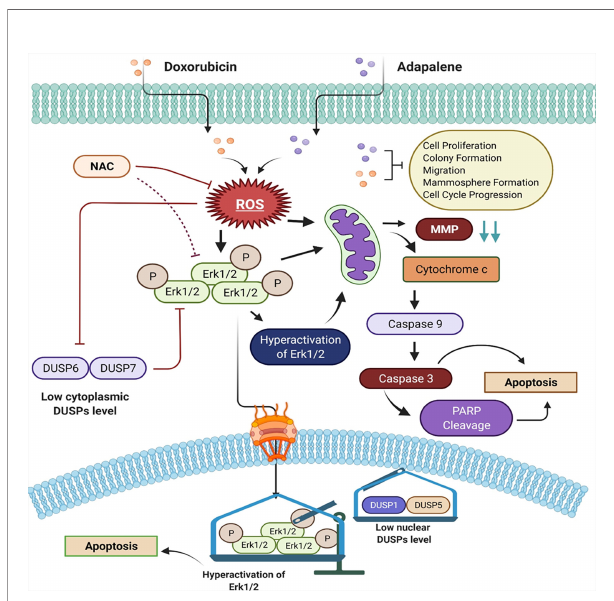
FIGURE 8 | Schematic of the main fi ndings of the study and possible mechanism of action of doxorubicin and adapalene in TNBC cells. The co- treatment with DOX and ADA resulted in enhanced ROS generation, leading to mitochondrial membrane potential disruption. Disruption of MMP triggers intrinsic apoptosis associated with PARP cleavage. Also enhanced ROS generation, triggers hyperactivation of Erk1/2 signalling, which further promotes apoptosis via mitochondrial death